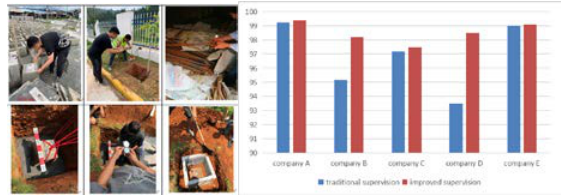
Figure 1 . Technical supervision site (left) and schematic diagram of quality control effect improvement